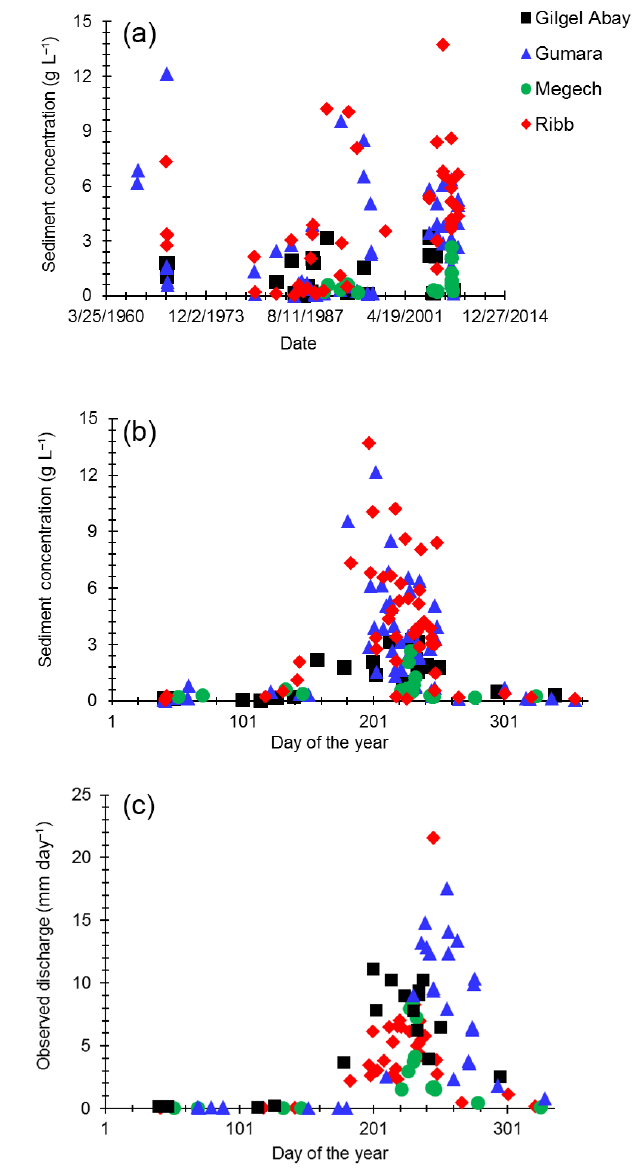
Figure 3. Observed sediment concentration and discharge for the four Lake Tana watersheds: Gilgel Abay, Gumara, Megech and Ribb. (a) Sediment concentration vs. date of sampling, (b) sediment concentration as a function of day of sampling independent of the year, and (c) observed discharge plotted vs. sampling